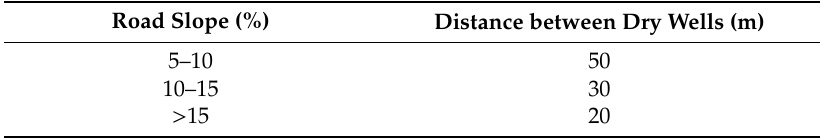
Table 1. Maximum spacing between the Dry Wells as a function of road slope. Road Slope (%)